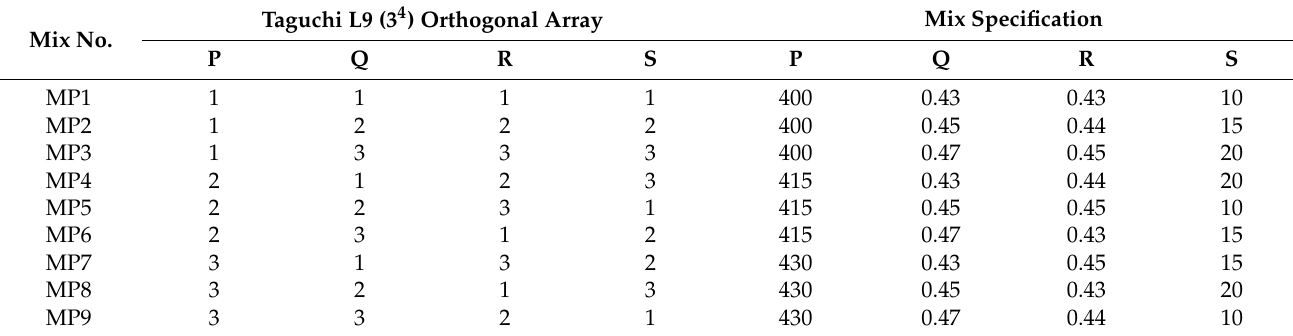
Table 6. L9 Taguchi OA and mix